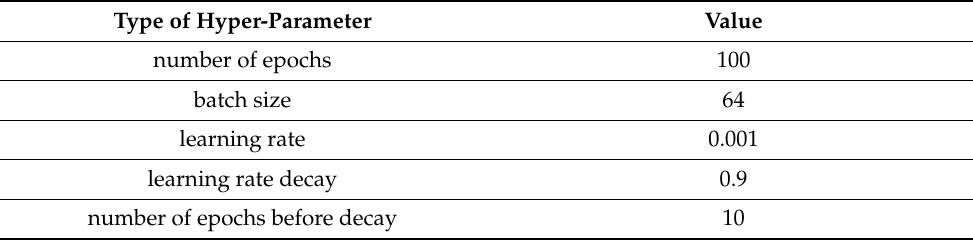
Table 1. Custom hyper-parameters for the CNN model. Type of